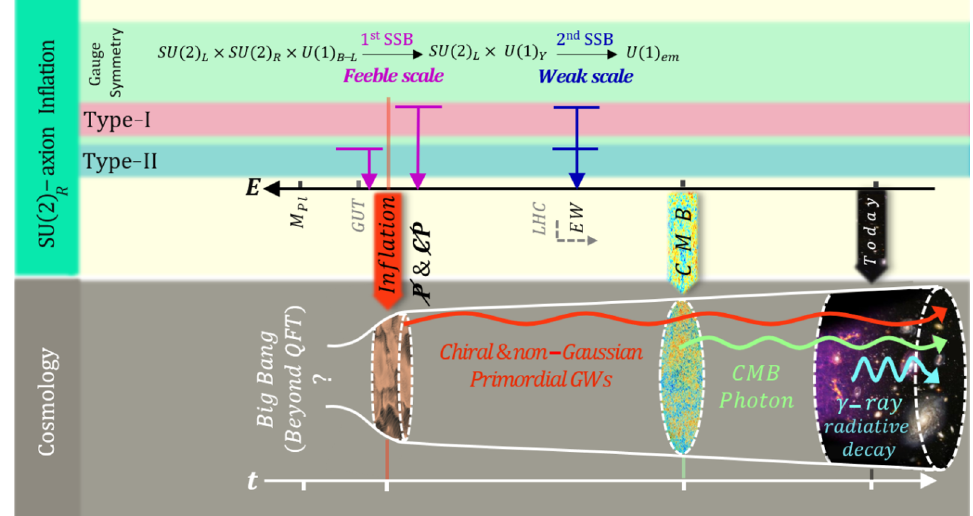
Figure 1 . The SU(2) R -axion inflation throughout cosmic history. This setup has two new funda- mental scales, scale of inflation Λ ( Λ Λ ) are called type- I (type- II inf < F